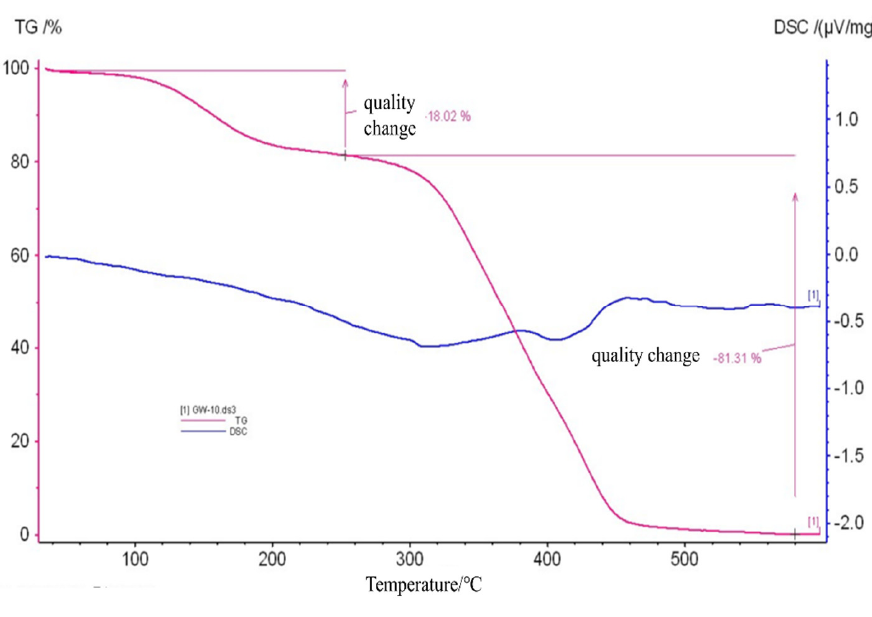
Figure 5. TGA/DSC curves of MG-MIM .